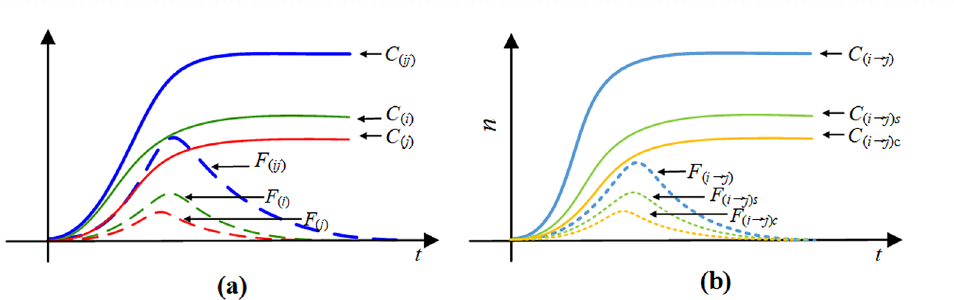
Figure 8. The temporal variation of the cumulative forwarding population and the active forwarding population: ( a ) the summative number of forwarding users; ( b ) the number of cross-transmission